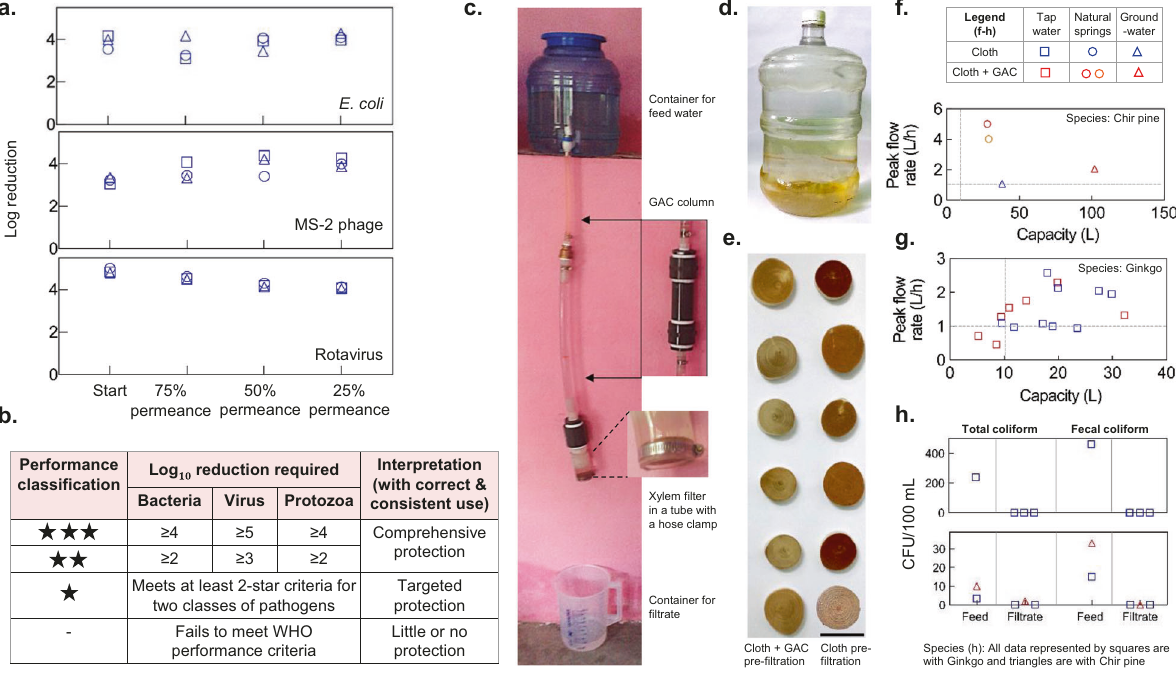
Fig. 5 Microbiological and fi eld performance. a Microbial removal performance of xylem fi lters (ginkgo, 4-cm diameter, 0.375-inch thickness, no pre- fi ltration) when operated under 1.2-m gravity head with general test water containing E. coli ( ≥ 10 6 CFU/mL) and MS-2 phage ( ≥ 10 5 PFU/mL) dosed simultaneously, or rotavirus ( ≥ 10 5 PFU/mL). Rejection was measured at the start of fi lter operation and when permeance dropped to 75, 50, and 25% of initial permeance (see “ Methods ” for further details). Different symbols indicate different fi lters. b World Health Organization (WHO) scheme for classi fi cation of household water treatment technologies. c Field setup for testing fi lter performance. d Tap water sample (New Delhi, India) used for testing. e Xylem fi lters used with granular activated carbon (GAC) show reduced deposits after fi ltration with tap water. Scale bar, 4 cm. f – h Chir pine and ginkgo fi lters show peak fl ow rates and capacity exceeding 1 L/h and 10 L, respectively, indicated by dashed lines in ( f ) and ( g ), and absence of coliform in the fi ltered water. Legend is shown at the top. In h , chir pine and ginkgo fi lters were used for tap water and groundwater studies, respectively. All data are obtained with 4-cm diameter, 0.375-inch-thick fi lters operated under 1-m head (see “ Methods ” for details on fi eld testing of fi lters). Each data point represents a different fi lter (one measurement per fi